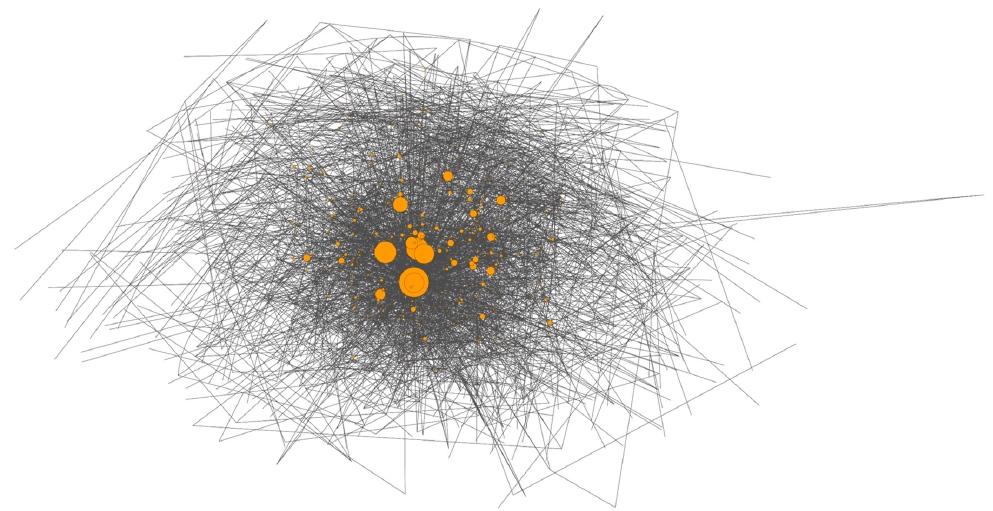
Figure 7. An undirected weightless simple graph of WEF nexus domain ontology analyzed by the network analysis method.